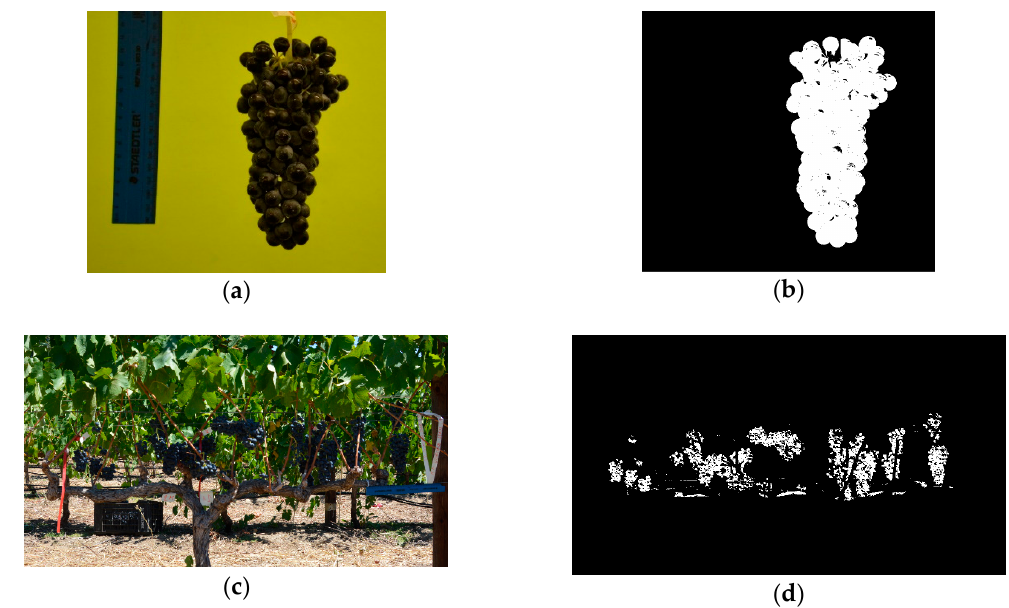
Figure 6. ( a ) Represents the original RGB image, with ( b ) illustrating the segmented binary image at bunch-level. ( c ) An RGB image of an east-facing vine, with ( d ) the segmented binary image at plant-level.